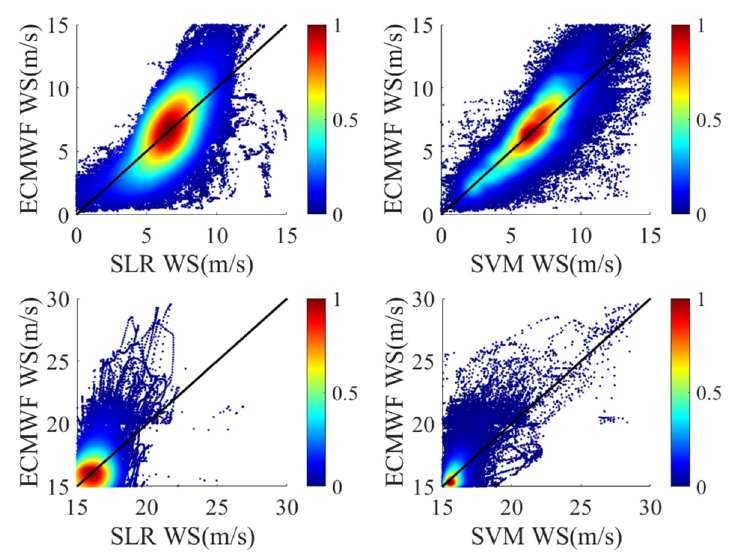
Figure 10. Results of wind speed retrievals based on SLR and SVM. Table 8. Retrieval performance of SLR and SVM.